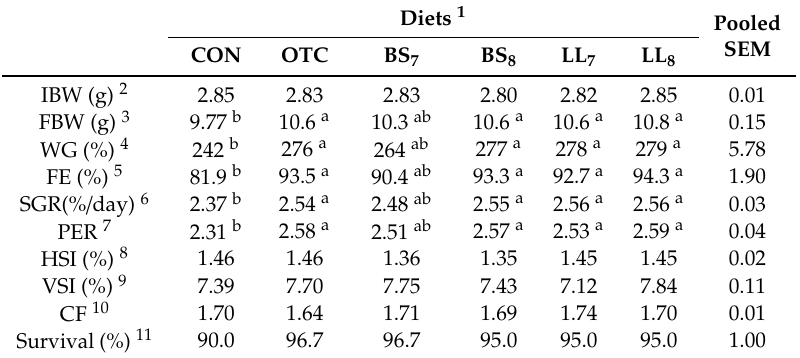
1 Values are means ± SD of triplicate groups of fish. Values in each row with di ff erent superscripts are significantly di ff erent ( p < 0.05). Diets: CON = the basal diet, refer to Table 1; BS 7 = B. subtilis at 1 × 10 7 CFU / g; LL 7 = L. lactis at 1 × 10 7 CFU / g; BS 8 = B. subtilis at 1 × 10 8 CFU / g; LL 8 = L. lactis at 1 × 10 8 CFU / g; OTC = oxytetracycline; oxytetracycline at 4 g / kg. 2 Initial body weight. 3 Final body